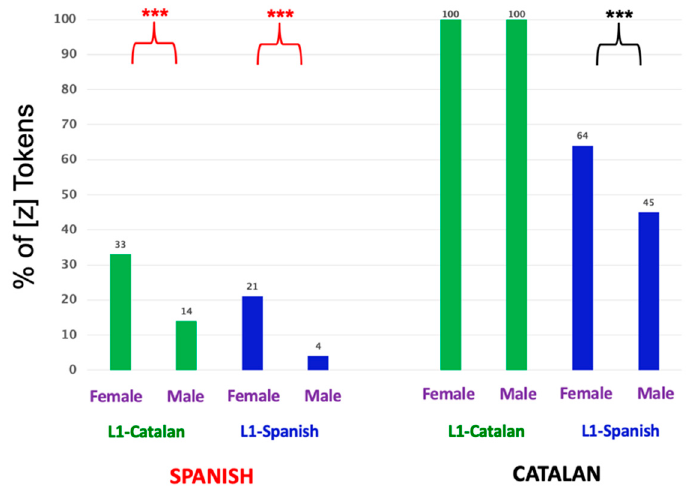
Figure 8. Effect of gender as mediated by language profile and language on Barcelonan fricative production.